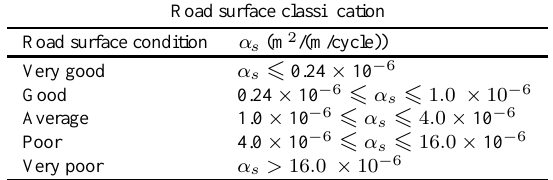
Table 1 Road surface